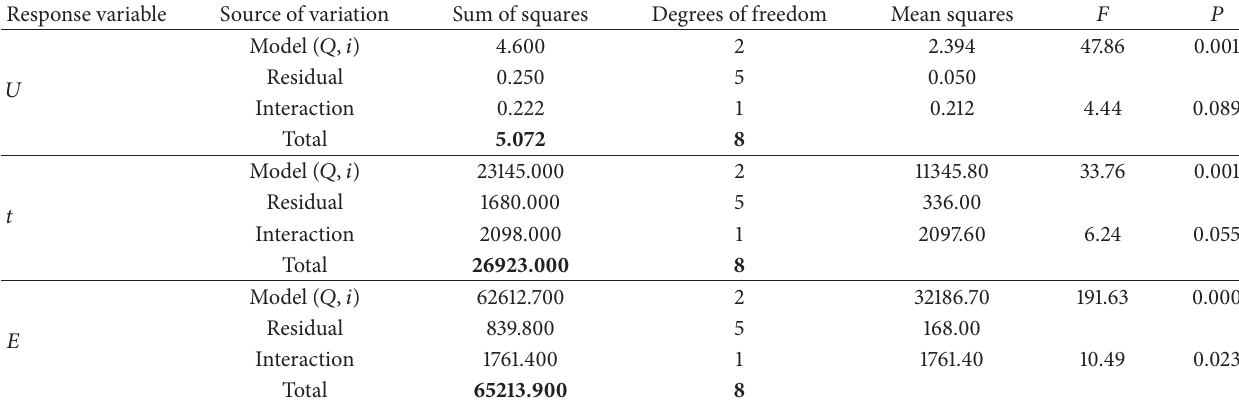
Table 4: Analysis of variance (ANOVA) for the variables investigated during the As electroremoval process, fitted to a quadratic model. Response